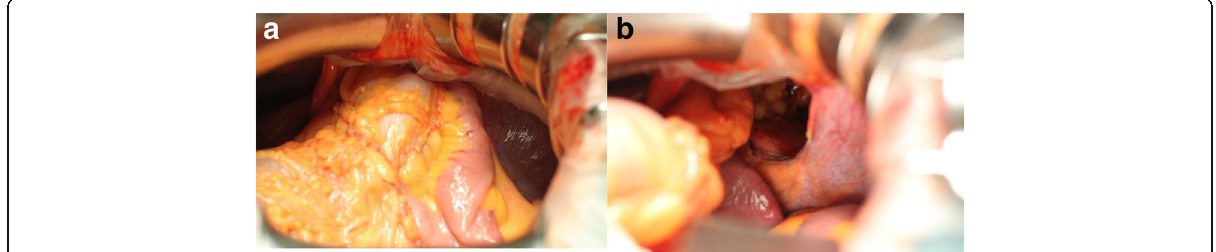
Fig. 2 Intraoperative photographs of case 1. a The small and large intestines were incarcerated in the retrosternal orifice. b The intestine was easily reduced into the abdomen. The retrosternal orifice was widely opened with a sharp